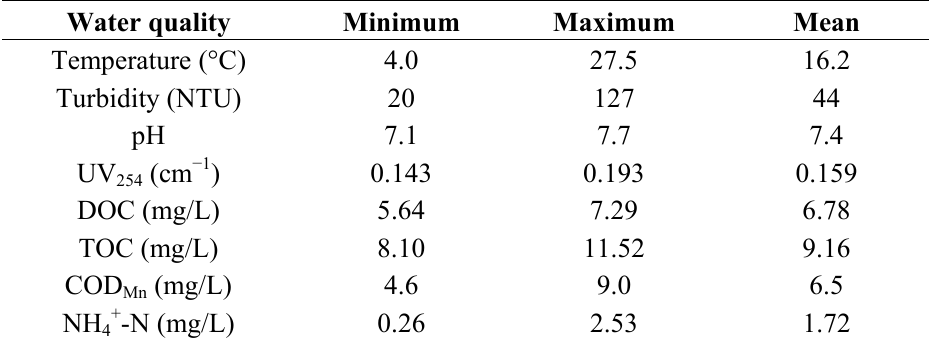
Table 1. Raw water quality during the experimental course (NTU: nephelometric turbidity unit; TOC: total organic carbon; COD : permanganate Mn